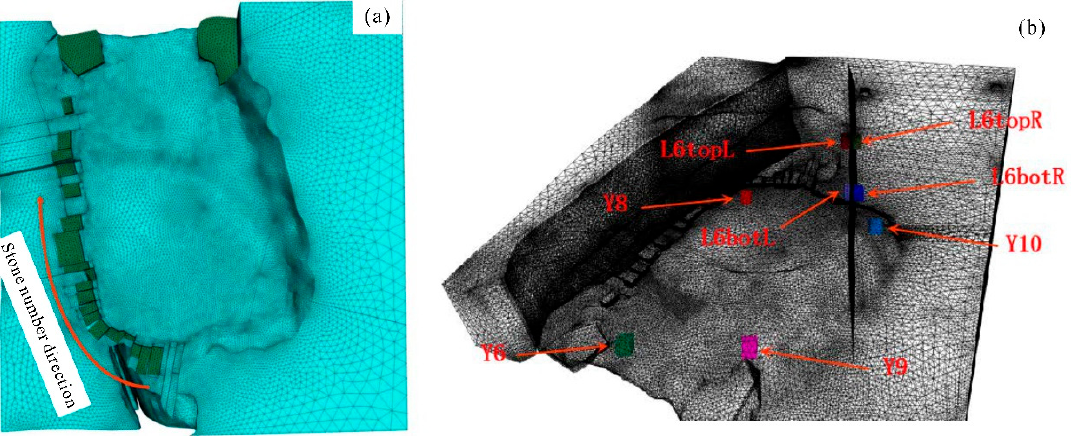
Figure 9. Three-dimensional geological model. ( a ) Schematic diagram of the development of over- hanging slates. ( b ) Location layout of the monitoring points. Table 3. Stratigraphic lithological parameters.